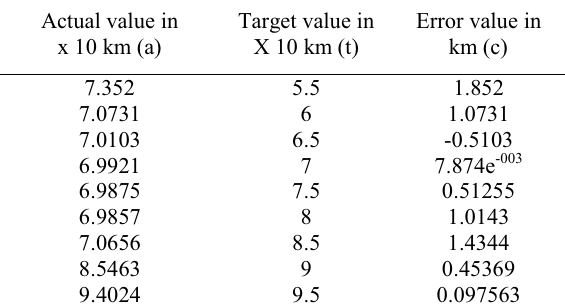
Table 3. Numerical values of the FL error of hybrid approach for double circuit of double line to ground fault (100-150km) Actual value in x 10 km